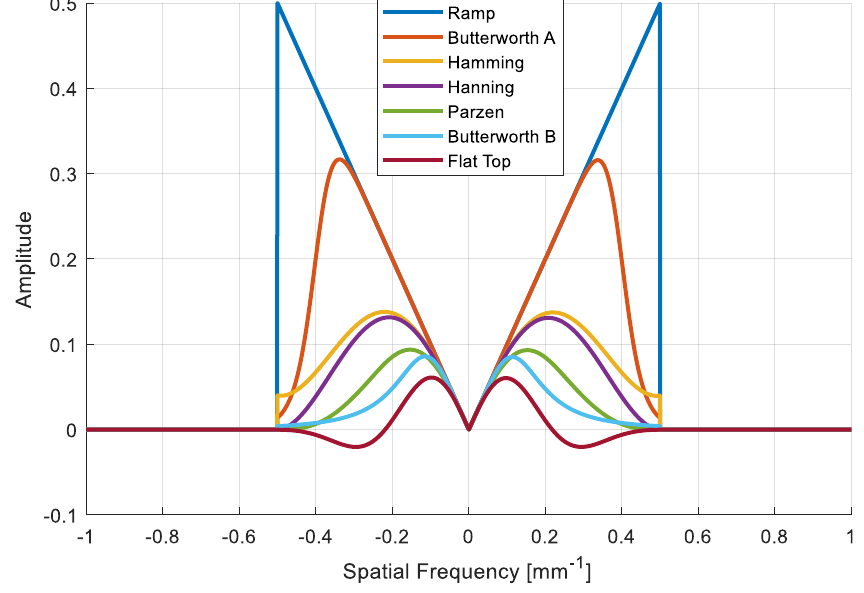
Figure 5. Different band-limited filter shapes as a function of frequency response.